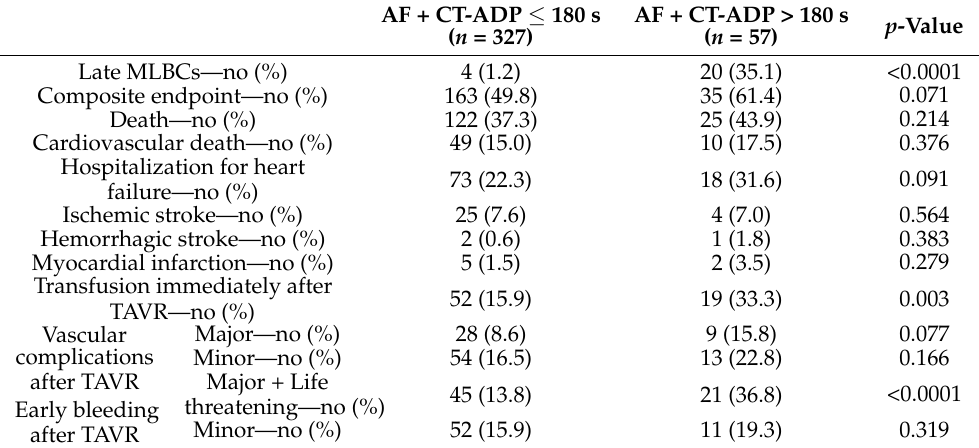
Table 3. Impact of atrial fibrillation and CT-ADP > 180 s on clinical